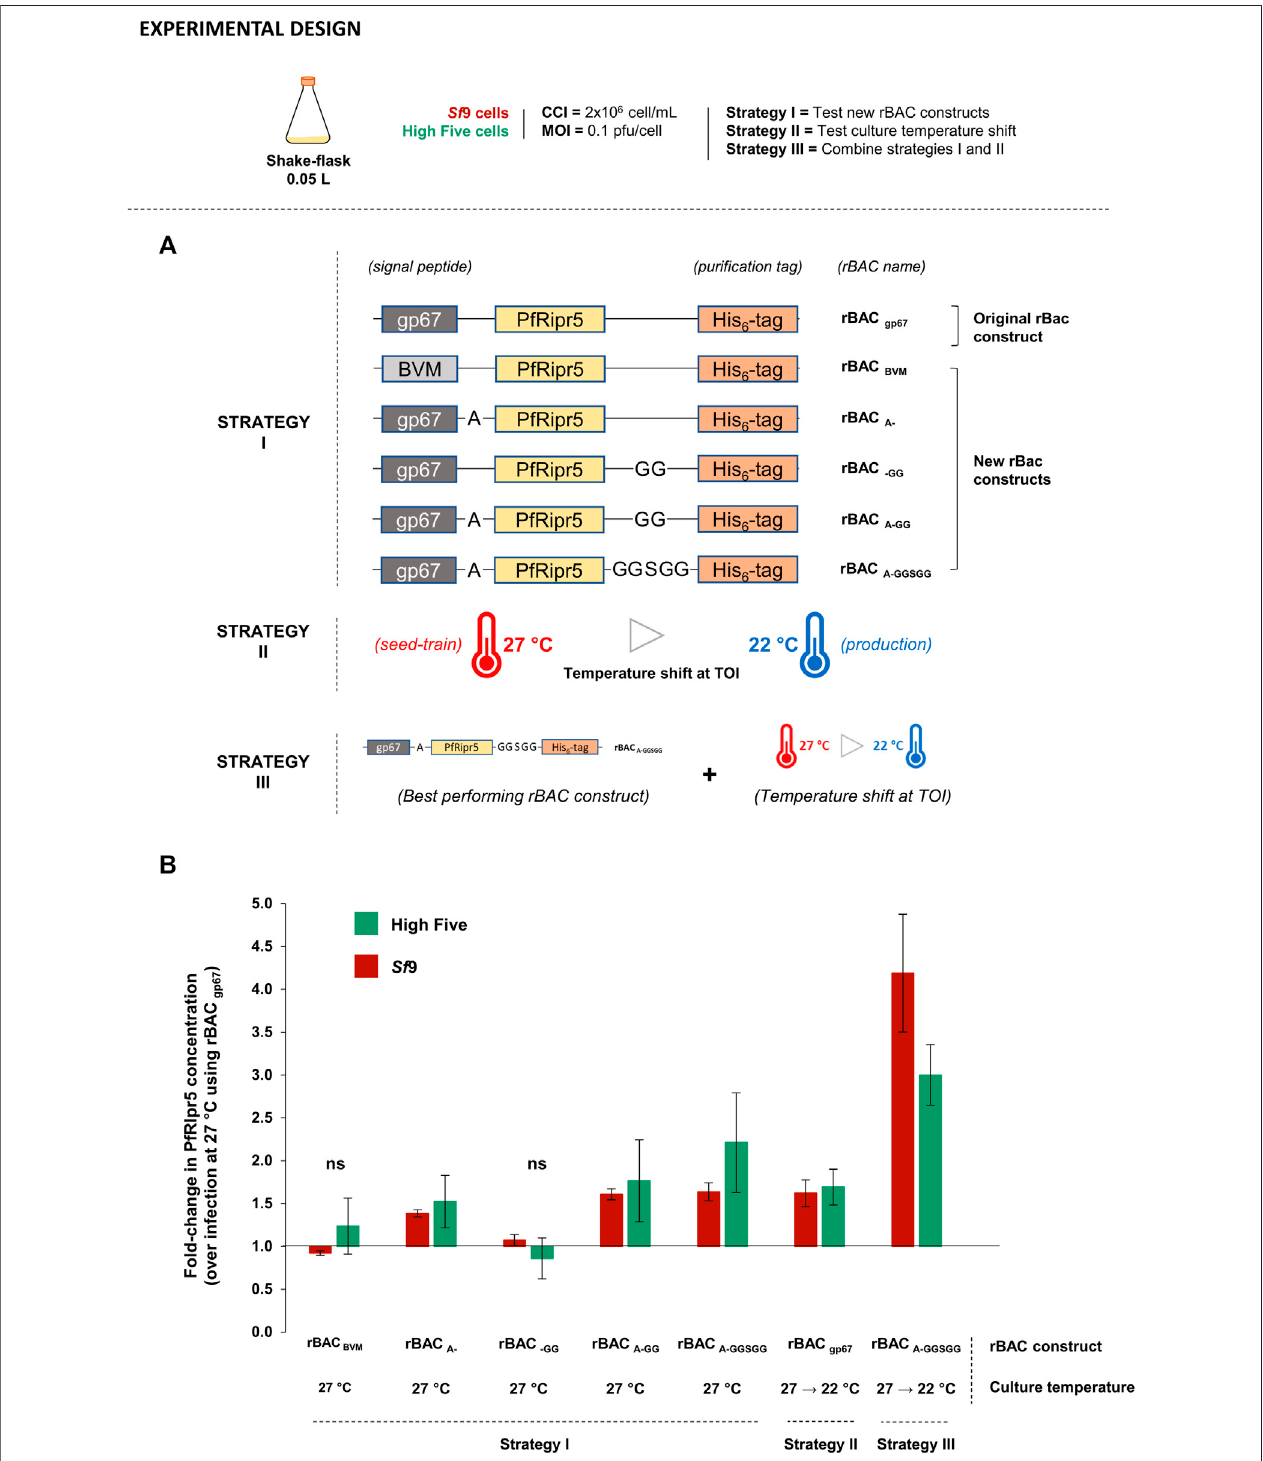
FIGURE1| OptimizationofPfRipr5productionusinginsectcells. (A) Optimizationstrategiesdevised. (B) RelativePfRipr5concentrationattheTOHbetweeneach optimization condition and the baseline production setup (infection with rBAC gp67 without culture temperature shift). A denotes alanine, G denotes glycine, and S denotes serine. Infections were performed using CCI = 2 × 10 6 cell/mL and MOI = 0.1 pfu/cell. Data are expressed as mean ± standard deviation and is relative to three biological replicates ( n = 3).